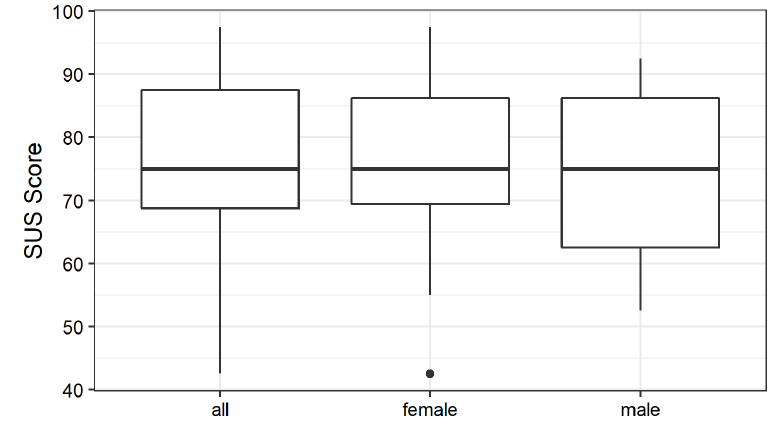
Figure 7. SUS score boxplots for all participants and by gender.